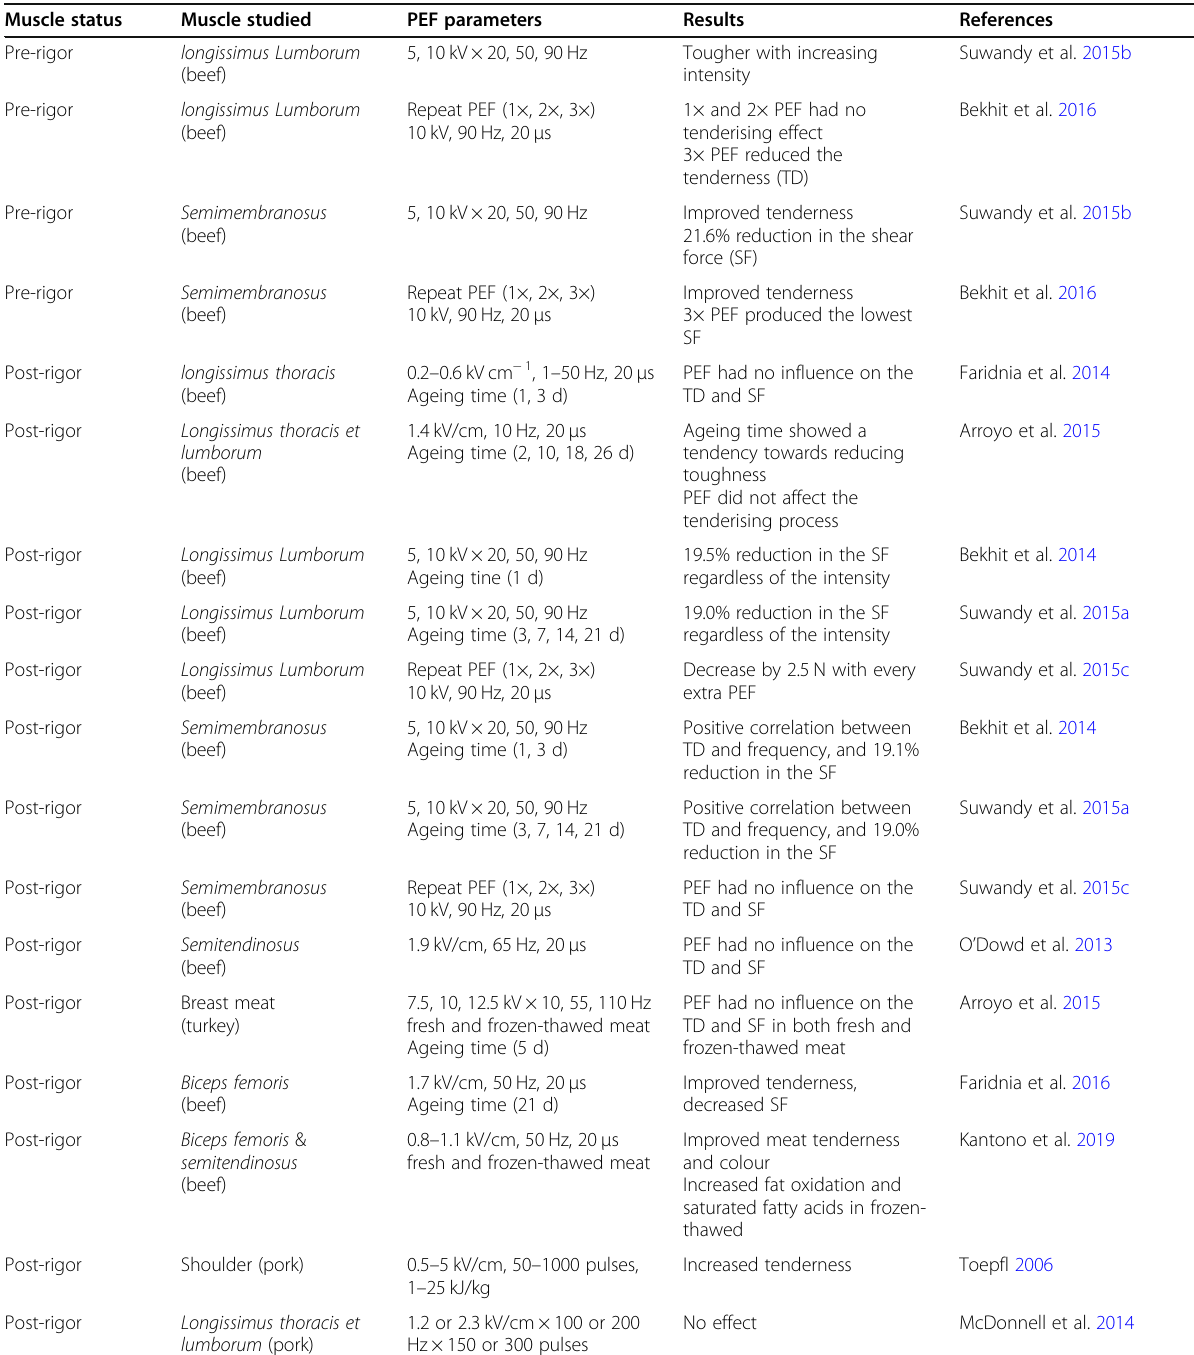
Table 2 The application of pulsed electric field in different status of